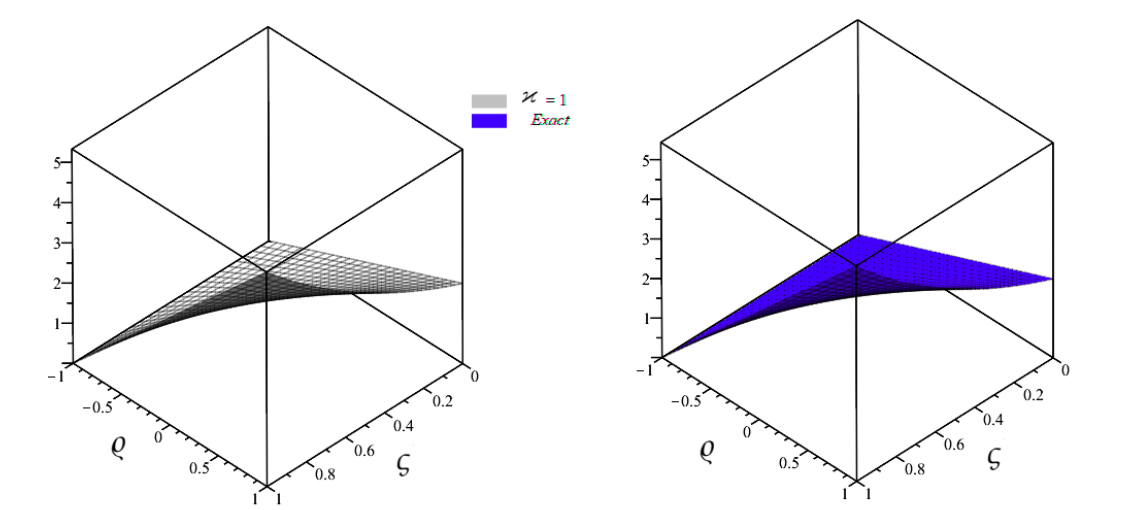
Figure 1. The exact and analytical solutions graph at κ = 1 for Problem 1.